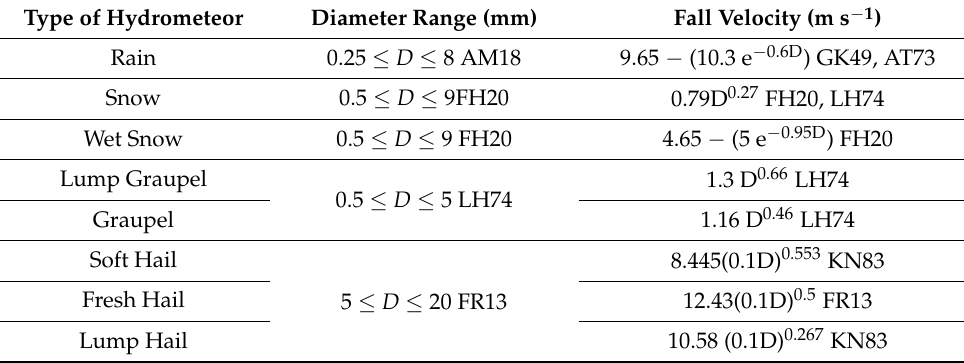
Table 2. Diameter range and fall velocity–diameter relationships used for the discrimination between: rain ([53], GK49; [59], AT73; [17], AM18), snow ([56], FH20; [54], LH74) wet snow (FH20), graupel (LH74), lump graupel (LH74), soft hail ([55], KN83; [24], FR13), fresh hail (KN83, FR13) and lump hail (KN83,